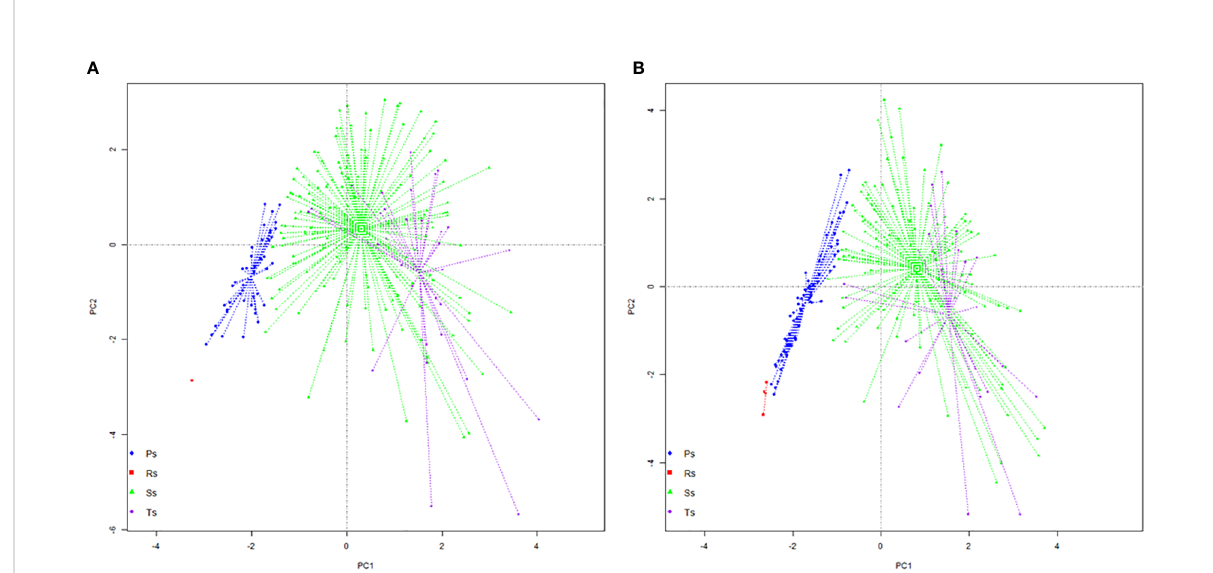
FIGURE 4 Principal component analysis (PCA) projection of speci fi c colonization strategies: (A) untreated plants and (B) treated plants. Ps, proliferation strategy; Rs, resistance conditions strategy; Ss, storage strategy; Ts, transfer